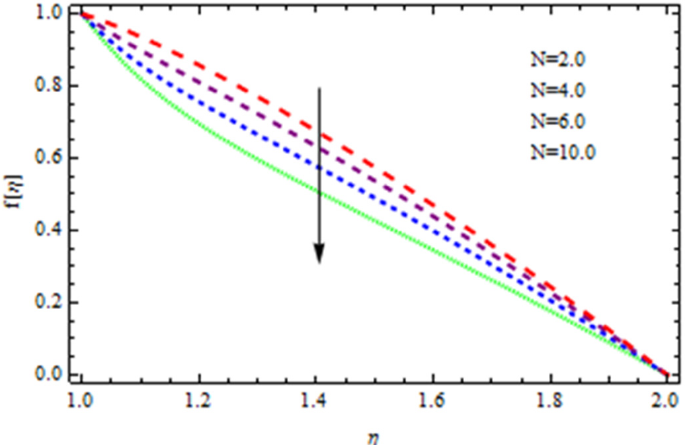
Figure 8. Influence of N on the velocity curve in the case of the Reynolds model.